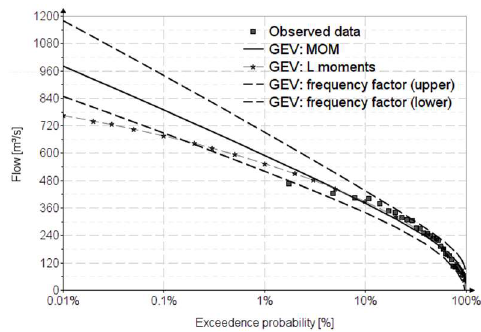
Figure 5. GEV distribution.